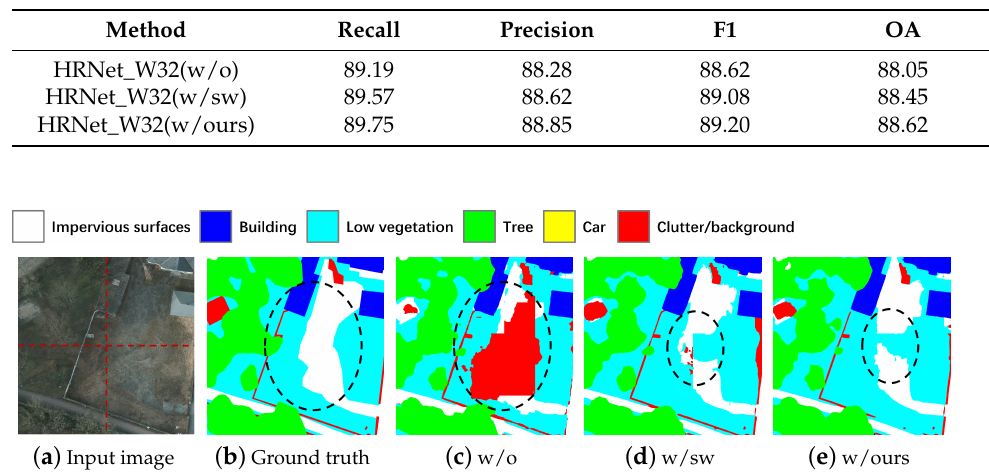
Figure 9. Comparation of the three postprocessing methods on the Potsdam